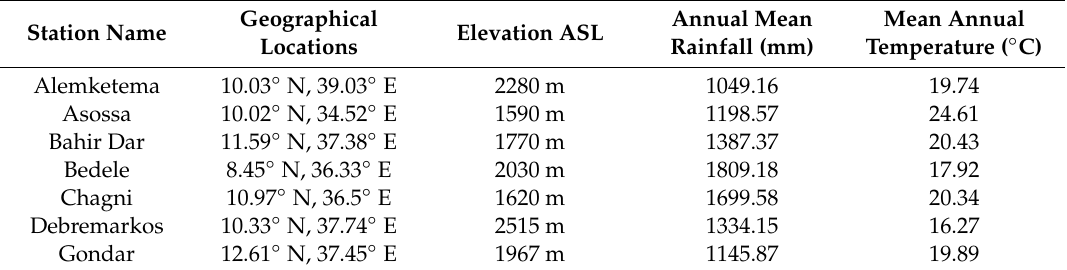
Table 1. Meteorological stations and their descriptive statistics.